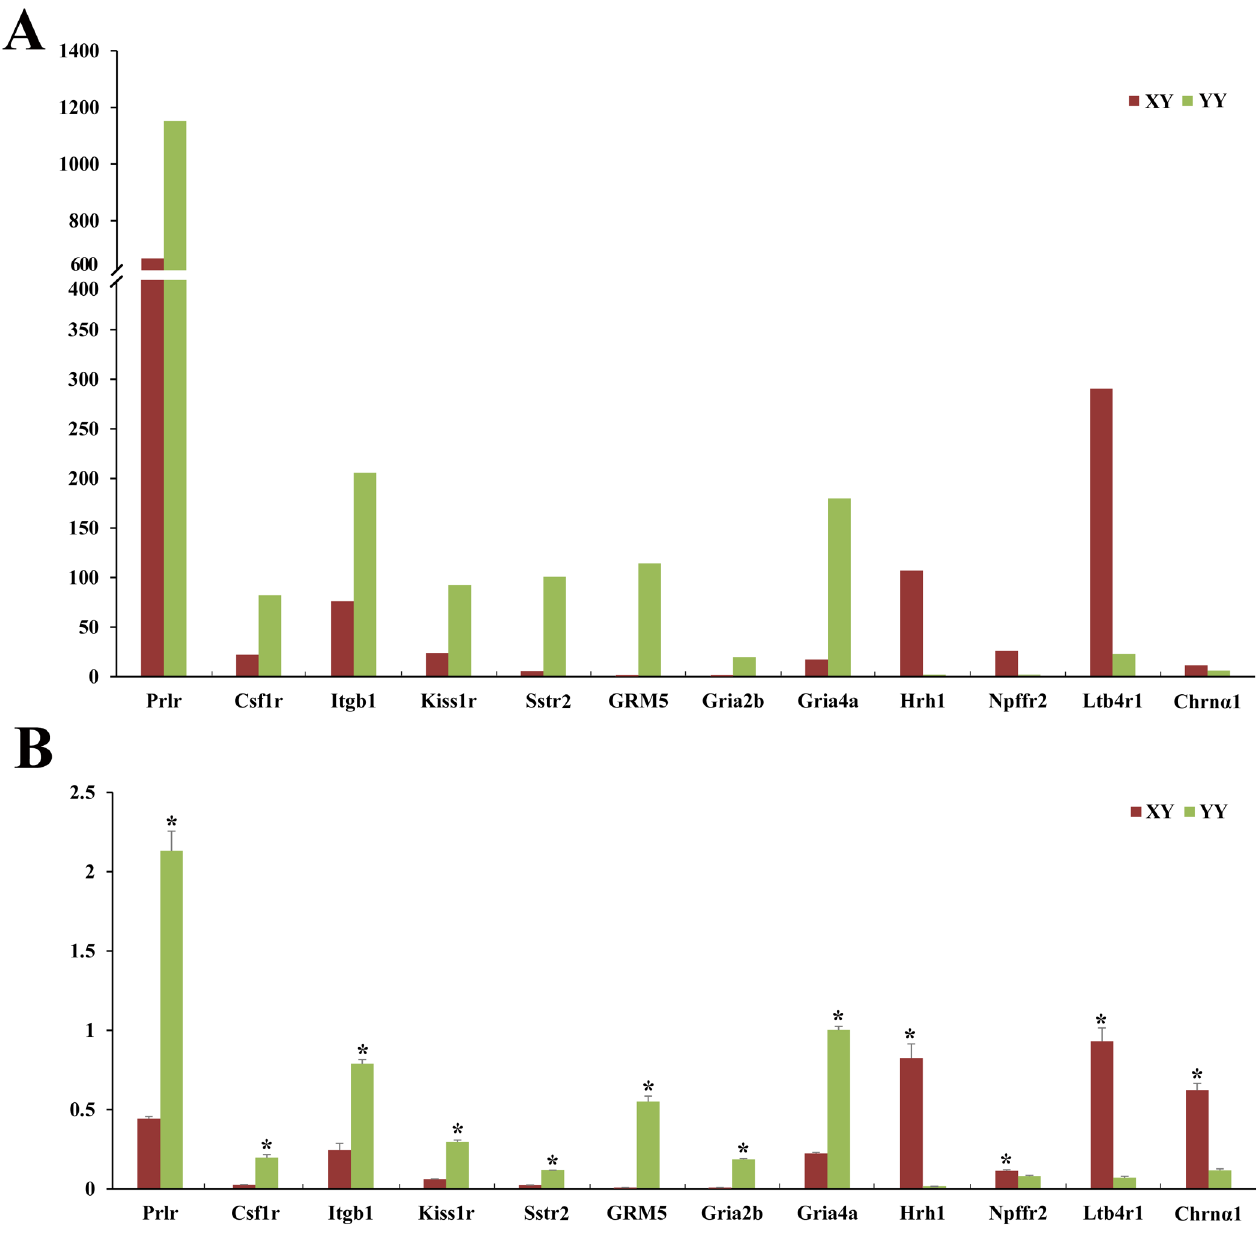
Fig 7. Concordance of solexa sequencing data with qRT-PCR data. (A) Profile of solexa sequencing value for selected genes with normalized expression data. (B) Profile of relative expression of selected genes by qRT-PCR. * p < 0.05 indicates the significant difference in gene expression between male (XY) and super-male